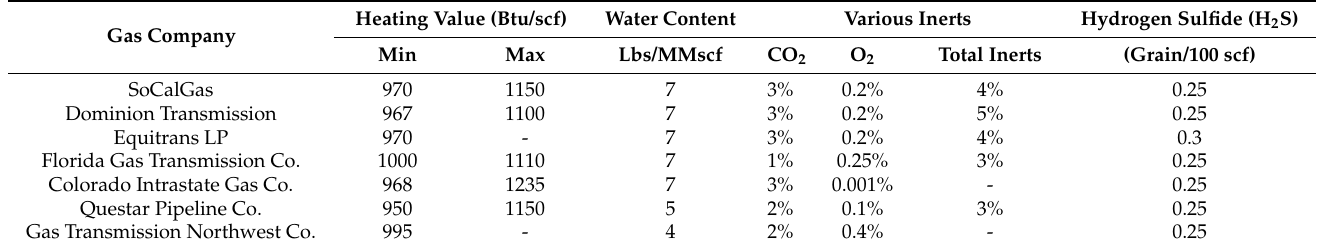
Table 7. Natural gas quality standards adopted by gas companies of the United States.